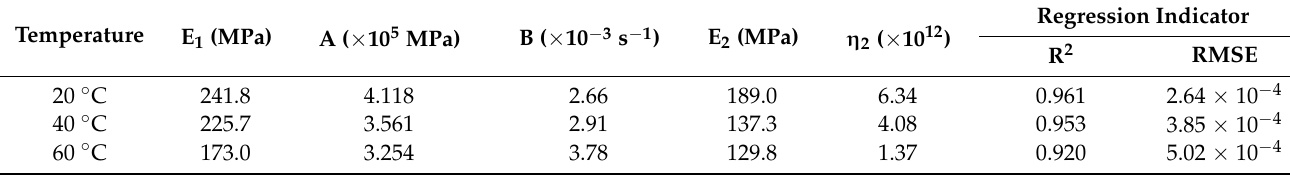
Table 6. Fitting parameters of the modified Burgers model.